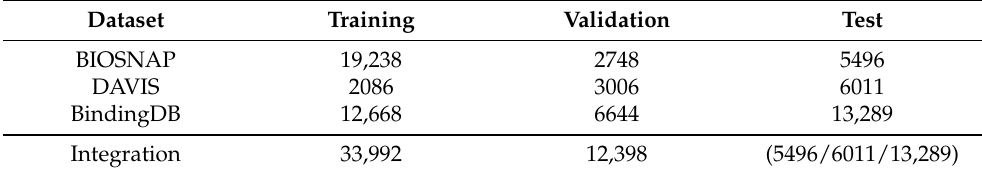
Table 2. Training, validation, and test data size for each dataset.